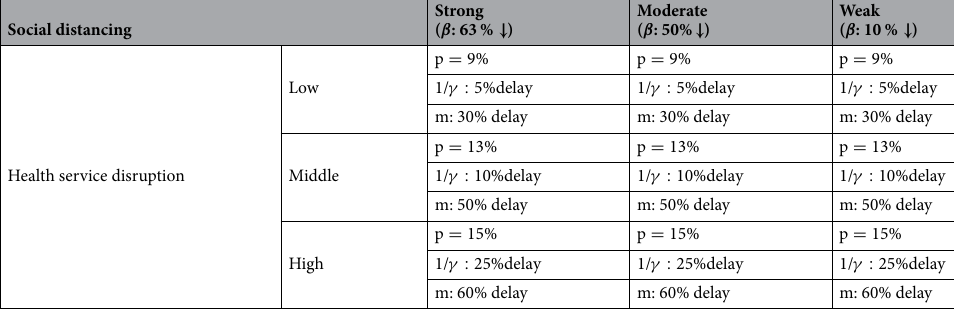
Table 2. Associated values used for each scenario. Summary of scenarios: The effect of social distancing is represented by strong, moderate, and weak levels assuming the reduction of transmission by 63%, 50%, 10%, respectively. The degree of health service disruption is denoted by low, middle, and high considering increase of treatment failures (9%, 13%, 15%), delayed diagnosis (5%, 10%, 25%), and reduction of the number of close contact management (30%, 50%, 60%).